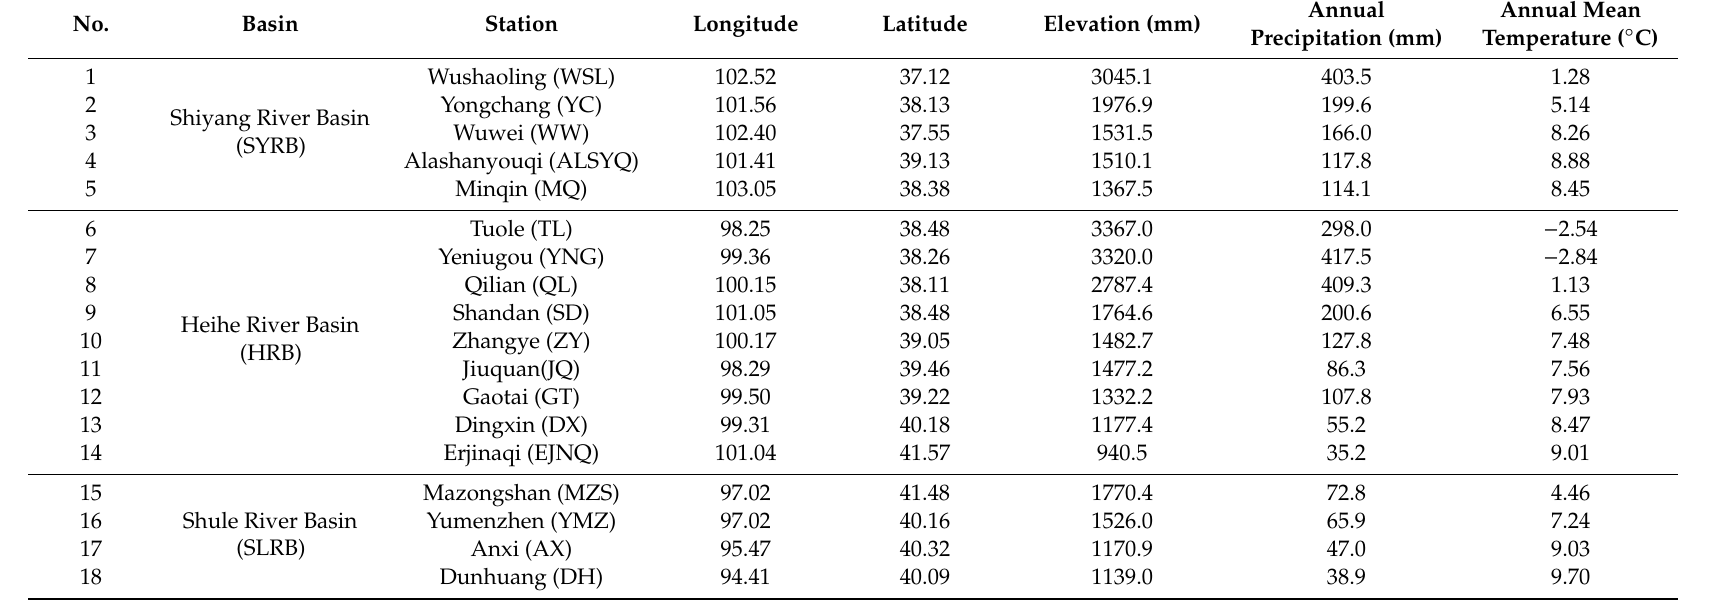
Table 1. Climate and geographical characteristics of the stations used in the study during